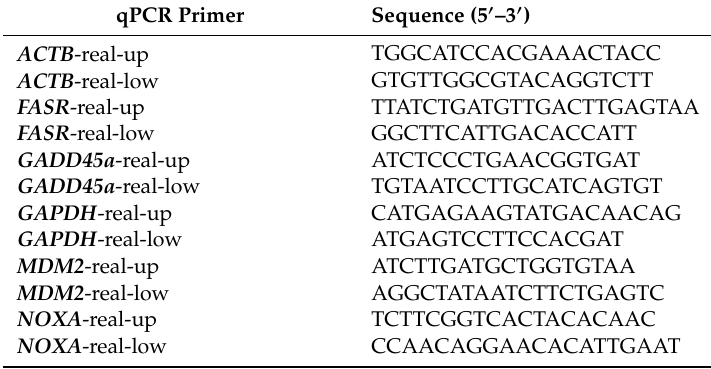
Table 1. Primers used for